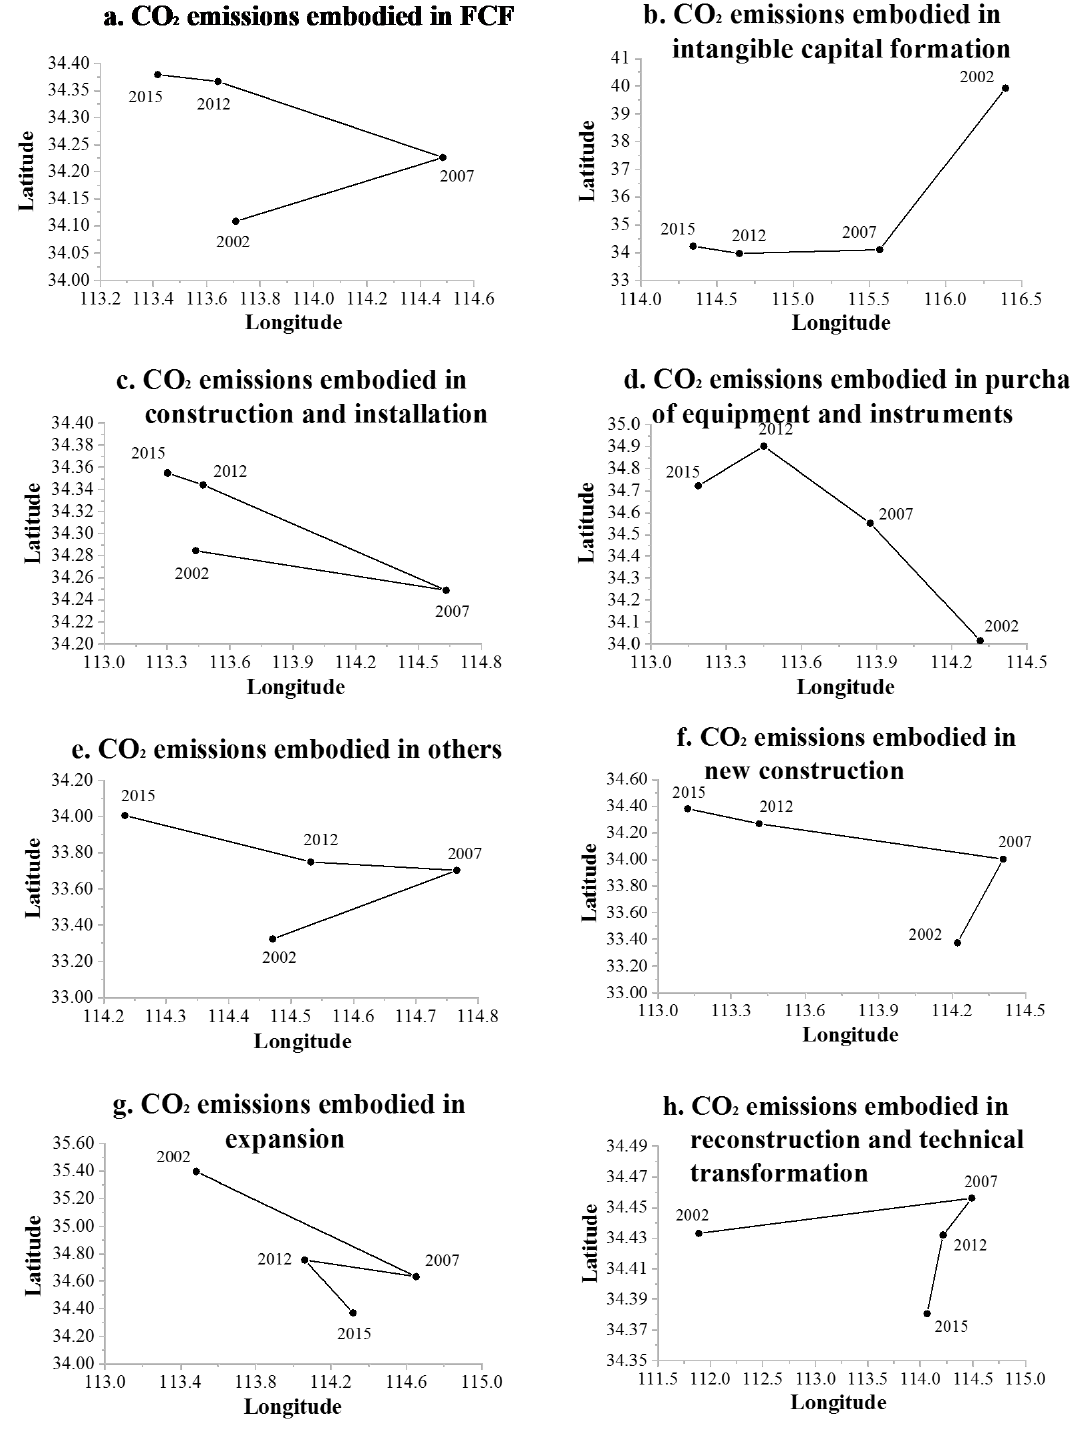
Figure 5. Gravity movements of China’s CO 2 emissions embodied in FCF.